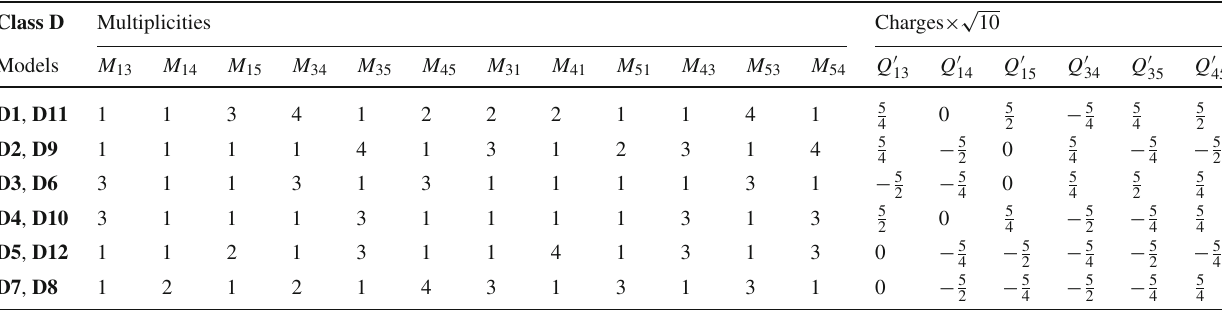
Table 18 Singlets spectrum of Class D models Class D